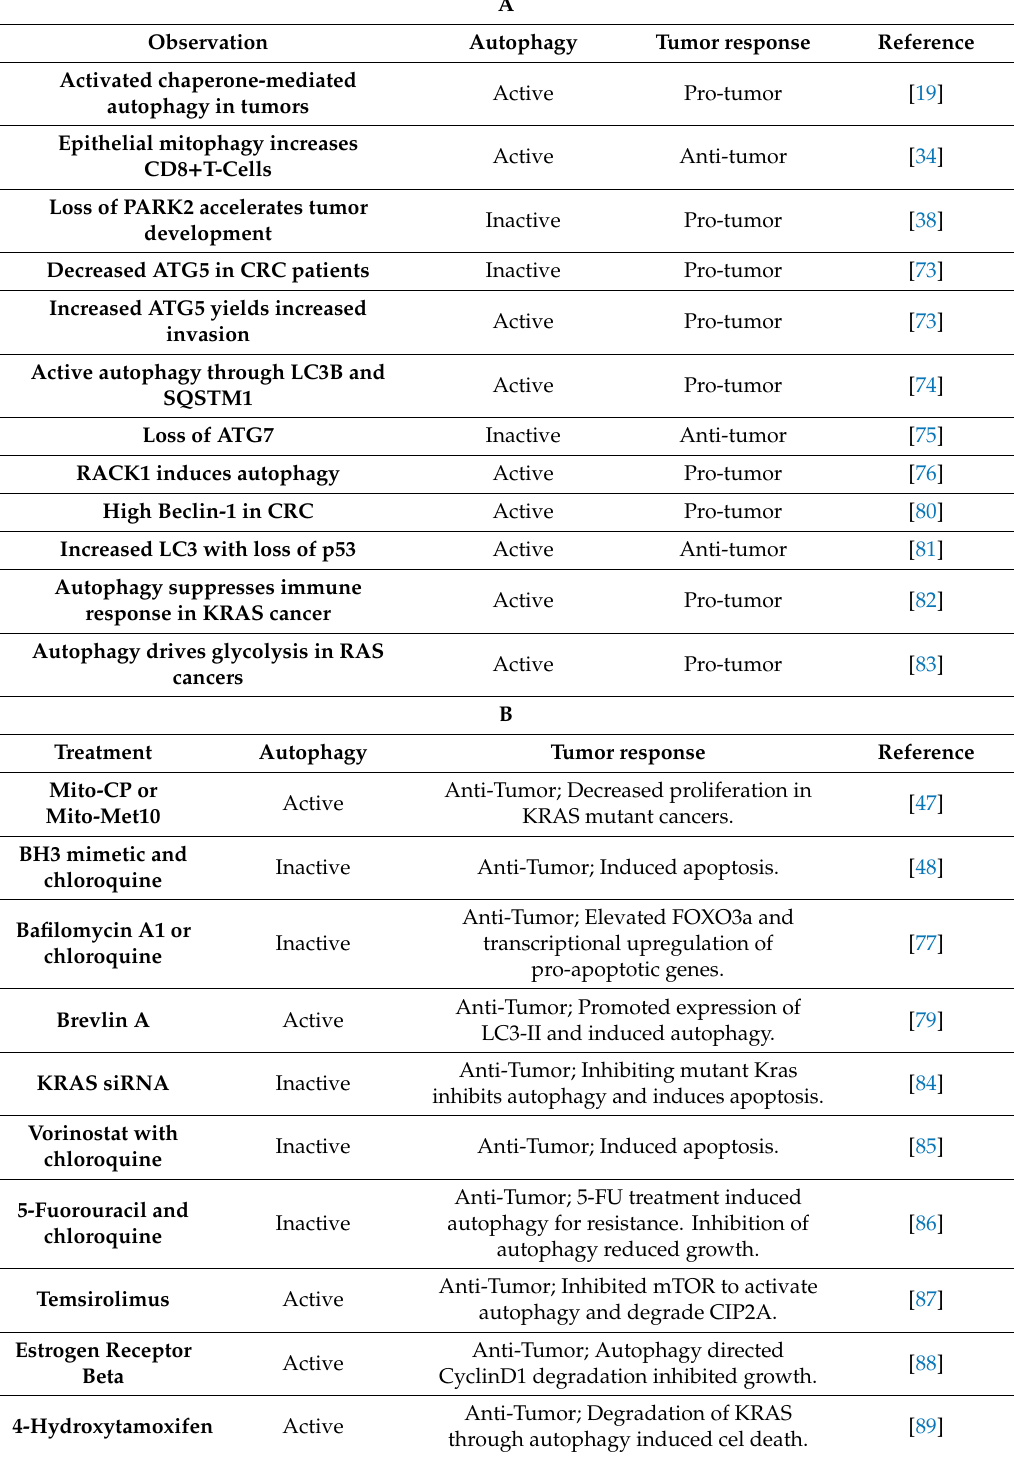
Table 1. Functions of autophagy in CRC. A . Observation / Autophagy indicates what mechanisms are observed in CRC tumors and if autophagy is active or inactive. Tumor response is a summary of whether or not the autophagy activity indicated generates a pro- or anti- tumor response. B . Summary of therapies and their modulation of autophagy. Treatment: Which therapy was employed. Autophagy: how the stated therapy modulated autophagy activation. Tumor response: how manipulation of autophagy via therapeutic treatment impacted tumor